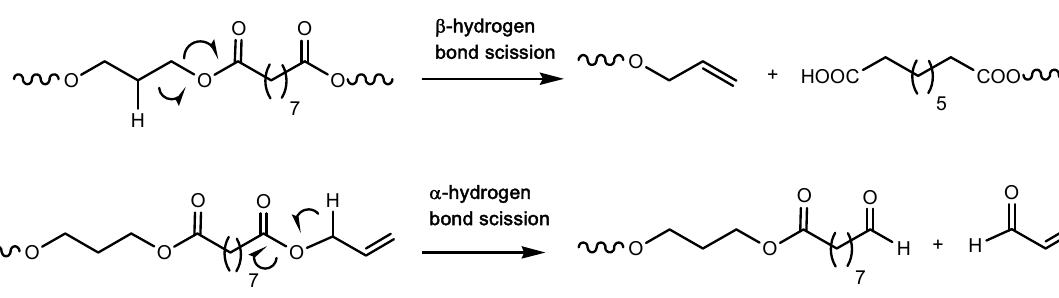
Figure 9. Schemes showing the β - and α -hydrogen bond scissions for aliphatic